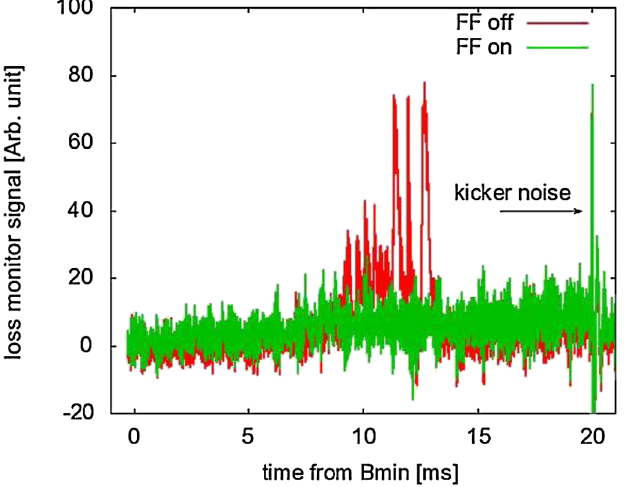
FIG. 20. Beam loss monitor signals at the arc section with the accelerating 300 kWequivalent beams. The beam loss is reduced by the feedforward.